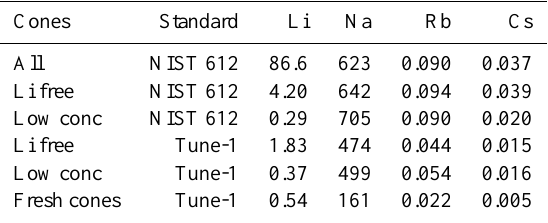
Table 3. Mean daily backgrounds in ppm equivalent. Low conc refers to cone set E-5, which was reserved for low-alkali samples. Li free refers to all cones except the dedicated high-alkali set. Clean cones is the background on freshly cleaned cones after tuning on the Tune-1 glass, before any analyses are